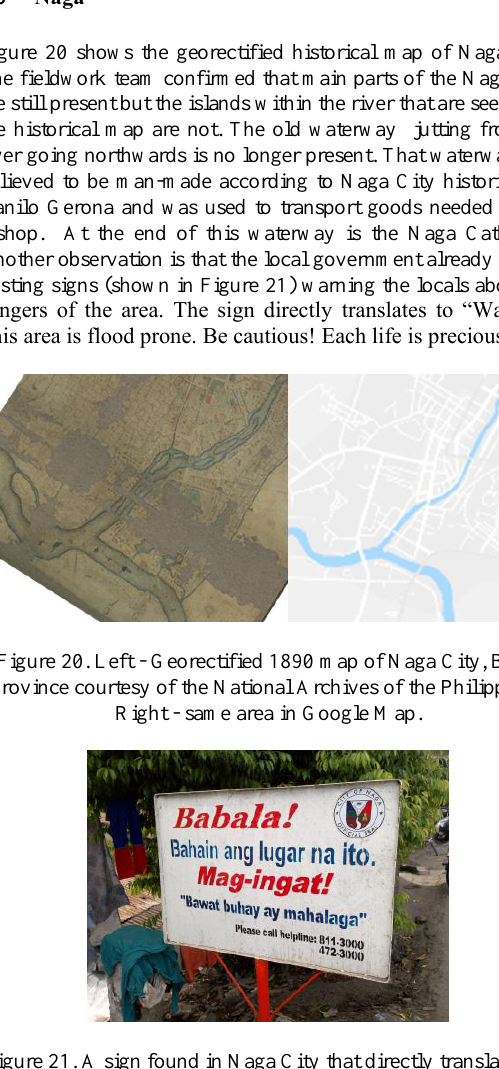
Figure 21. A sign found in Naga City that directly translates to, "Warning! This area is flood prone. Be cautious! Each life is